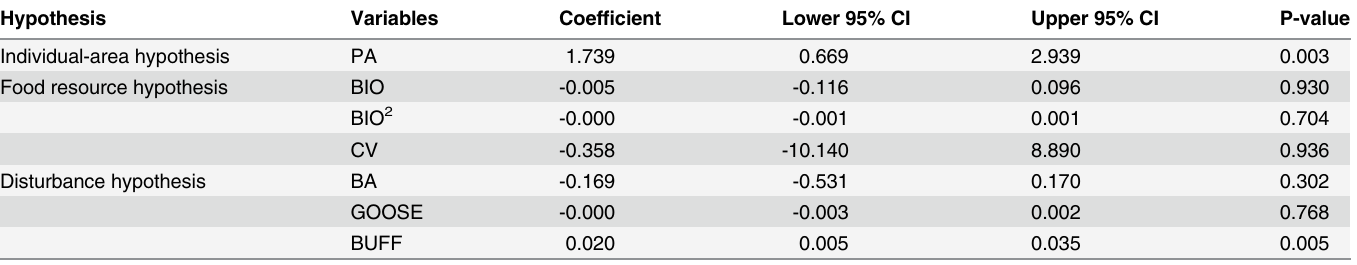
Table 4. Summary of the effects of dependent variables on greater white-fronted goose density as generated by the MCMCglmm model for each of the hypotheses and independent variables, with coefficients and p-values. Hypothesis